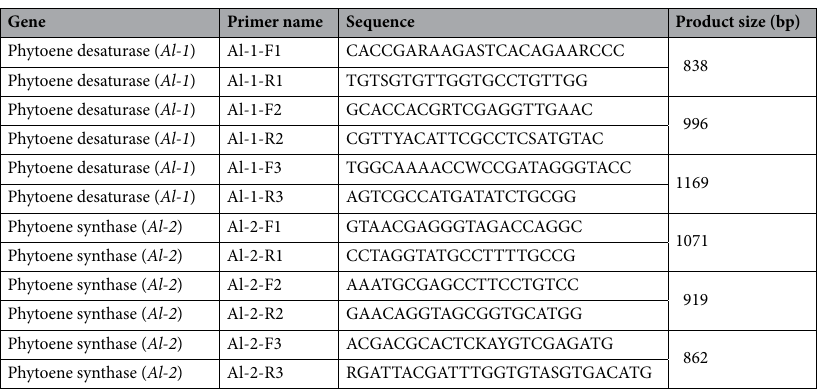
Table 5. PCR primers designed to amplify portions of the phytoene desaturase gene ( Al-1 ) and phytoene synthase gene ( Al-2 ) from Cantharellus species, based on genomic sequences from Cantharellus appalachiensis , C. cibarius , and C. cinnabarinus 18 , listed in “Materials and methods”